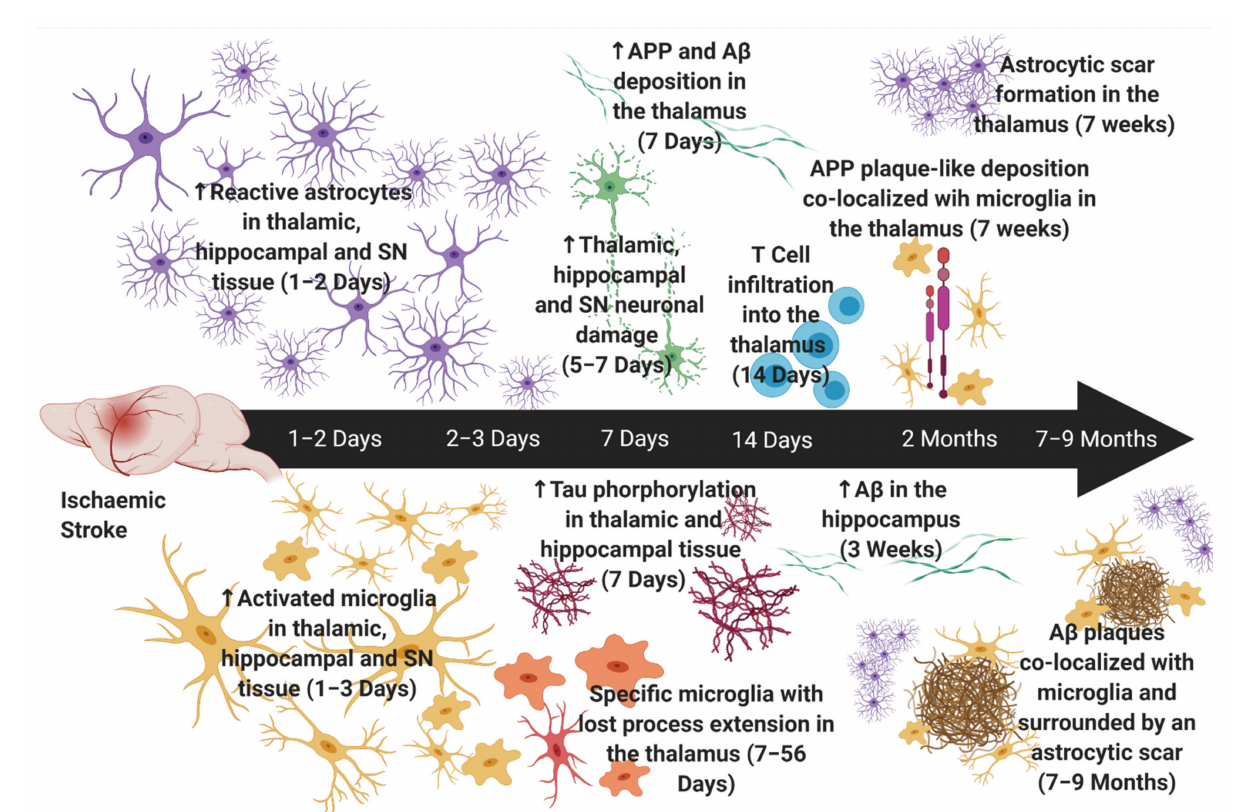
Figure 1. Neuroinflammation in Secondary Neurodegeneration following Experimental Stroke. Astrocytes are first increased within the thalamus, hippocampus and substantia nigra (SN) at ~one to two days post-stroke [32,185,186]. Astrocytic scar formation is first apparent in thalamic nuclei at seven weeks post-stroke [51]. Activated microglia are first increased within the thalamus, hippocampus and SN at one to three days post-stroke [177], with specific microglia (loss of process extension with intact phagocytotic functioning) seen in the thalamus at seven days and up to fifty-six days post-stroke [173,202]. Neuronal damage is noted after glial reactivity (~five to seven days) [185,186,199]. Tau phosphorylation in the thalamus [46] and hippocampus [48], and A β and APP deposition in the thalamus, is observed at seven days post-stroke [43]. Conversely, A β in the hippocampus is not apparent until three weeks post-stroke [47]. T cell infiltration into the thalamus is observed at fourteen days post-stroke [184]. APP deposition adopted plaque-like morphology and was colocalized with microglia at seven weeks post-stroke and A β plaques were colocalized with microglia at seven months [174] and was surrounded by an astrocytic scar at nine months post-stroke [43]. ‘ ↑ ’ denotes an increase. Created with BioRender© (https://biorender.com) (accessed on 30 November